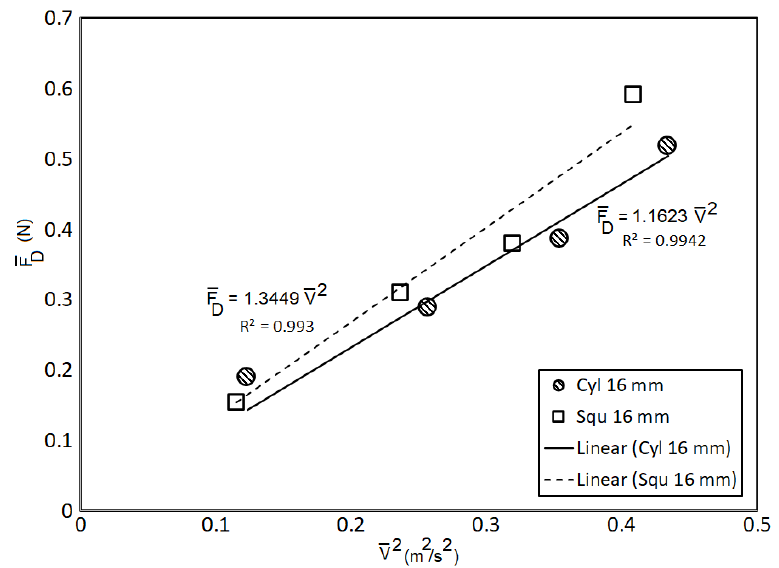
Figure 20. Linear correlation between the drag force and V 2 (square of the velocity) can be used to obtain the drag coefficients. The high R 2 numbers suggest that the linear regression fits the data very well. The gradient for the square bar data (empty square markers) is slightly higher than that of the cylindrical bar (circle markers).